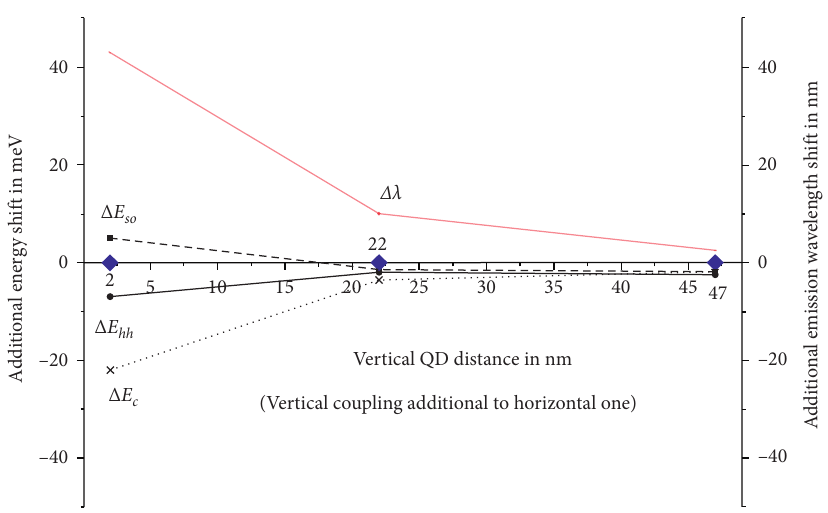
Figure 4: Numerical results on the impact of additional vertical/cross-plane coupling of 3 × 3 GaAs 0.3 Sb 0.7 QDs on GaAs arranged in two 3 × 3 square arrays on top of each other with a nominal horizontal QD distance of 2nm. The nominal vertical QD distance is 2nm, 22nm, or 47nm, respectively. The lines are only guides to the eye. The quantities ΔE c , ΔE hh , and ΔE so denote the energy shifts again, but now only the additional shifts due to vertical coupling. Mean values are given here. For the hh and the so hole energy level shifts, the differences for both central QDs are negligible anyway. But for the conduction band edge shift, the differences are not negligible. Also, the mean values for the wavelength shifts Δλ are